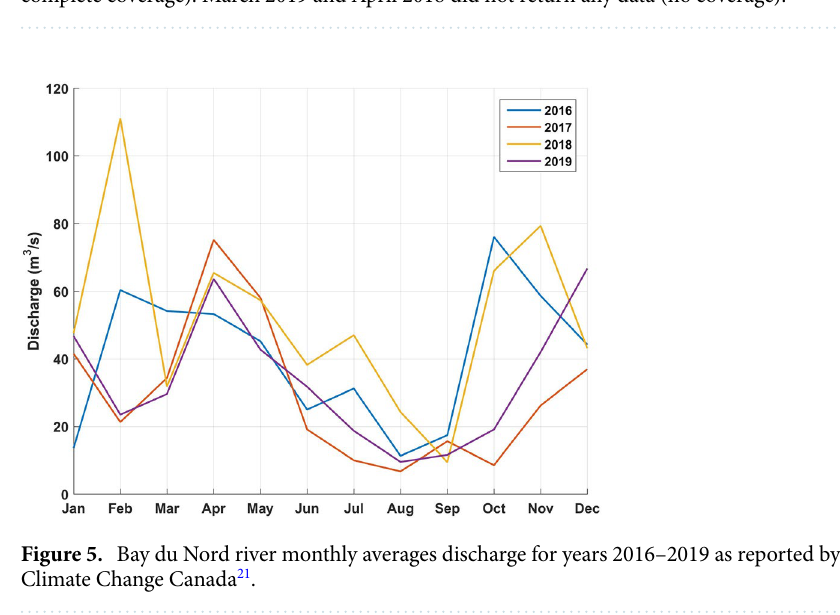
Figure 4. Sea Surface Temperature (SST) monthly averages for 2016–2019 of the study area ( N = 128 in complete coverage). March 2019 and April 2018 did not return any data (no coverage).